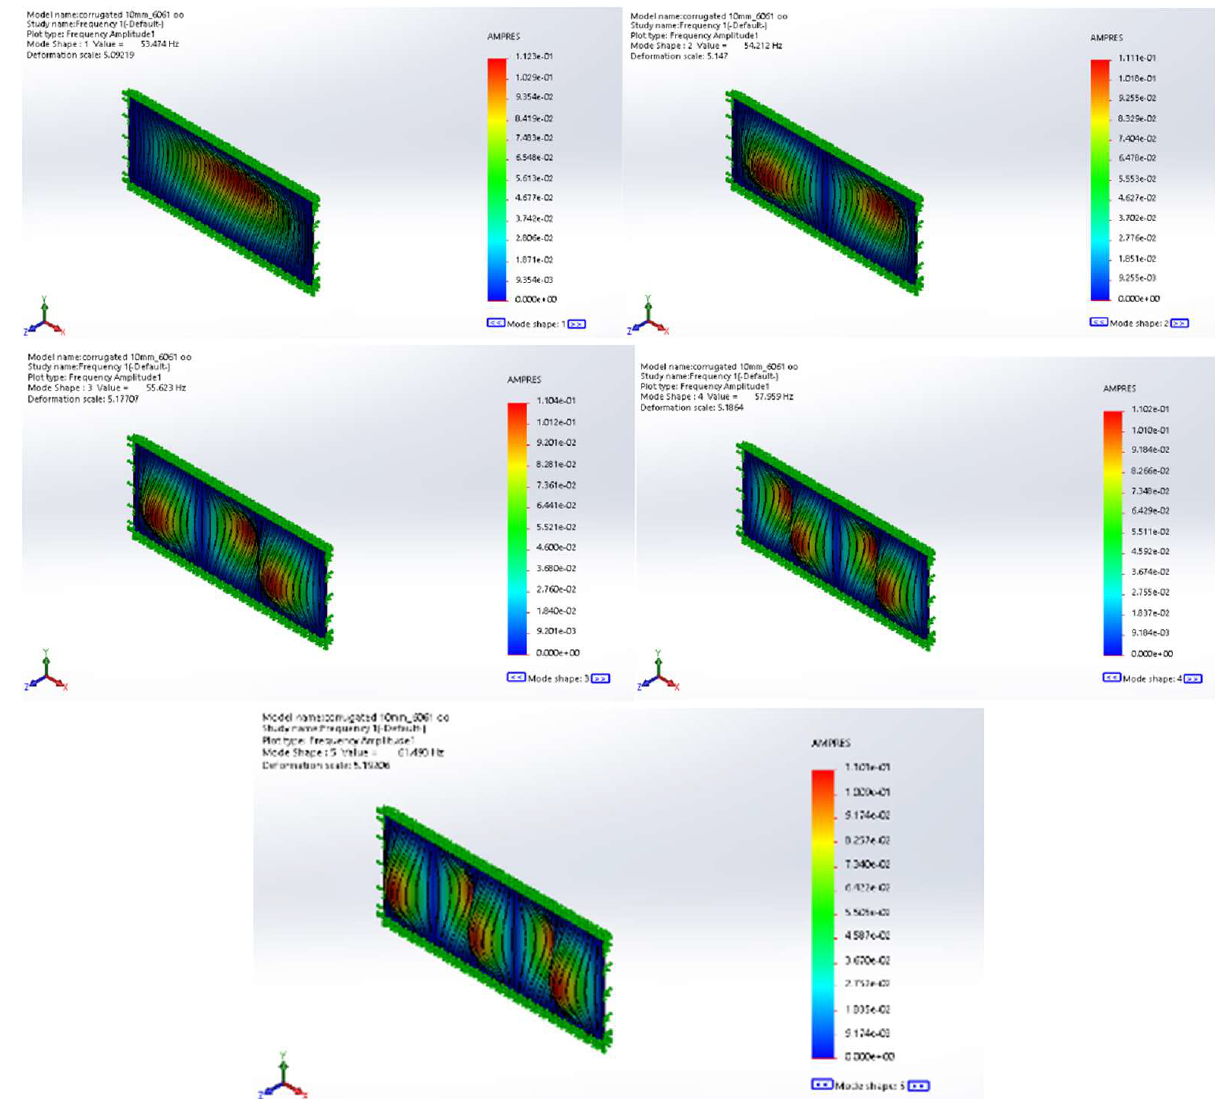
Figure 29: Mode shapes 1–5 of the corrugated